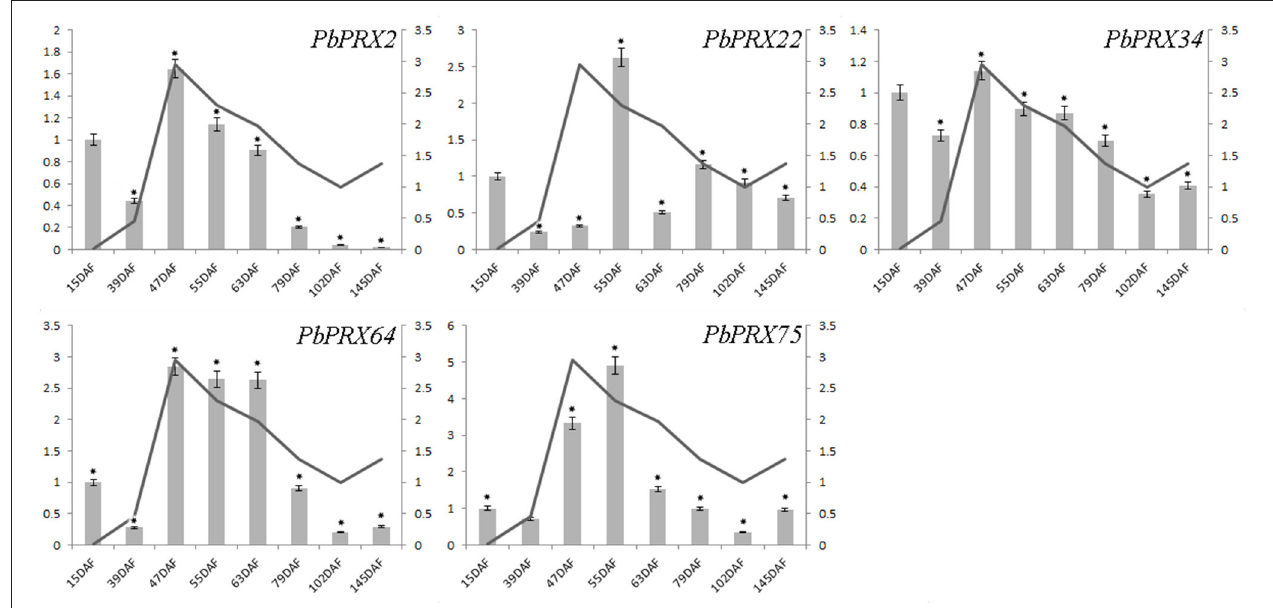
FIGURE 8 | Comparison of relative expression levels of five PbPRXs involved in lignin synthesis and content of stone cells during fruit development in Pyrus bretschneideri . Y- axes on the left indicates the relative gene expression levels:15, 39, 47, 55, 63, 79, 102, 145 DAF (X-axis) by bar charts, and the Y- axes on right showed the content of stone cells during fruit development with line charts. Each histogram represents the mean value and the bar ± standard error of three biological replicates. *significant difference at P <